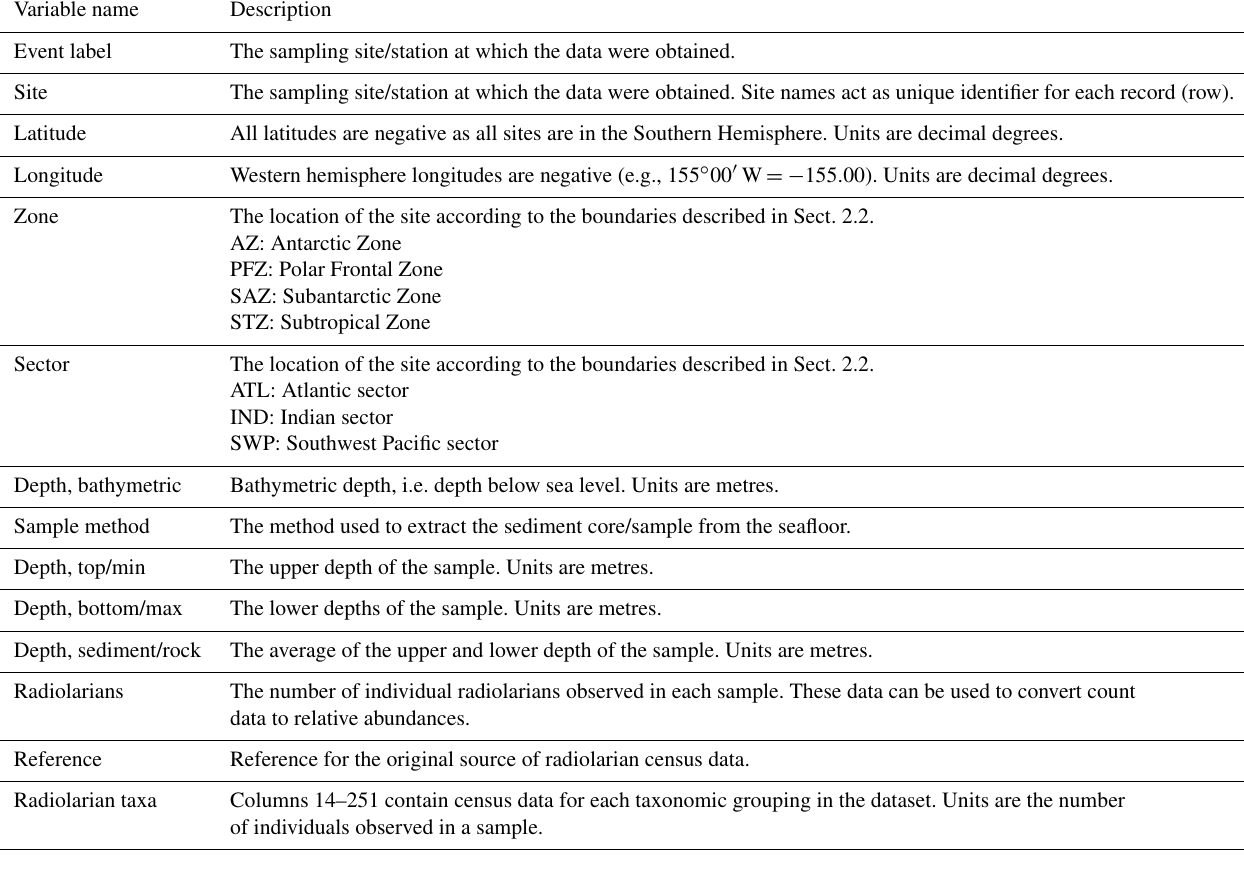
Table 1. Description of variables in the SO-RAD dataset.